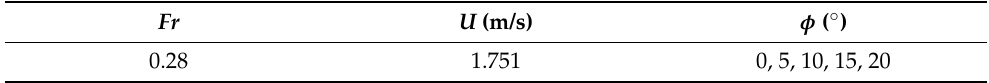
Table 6. Calculation cases of pure heel